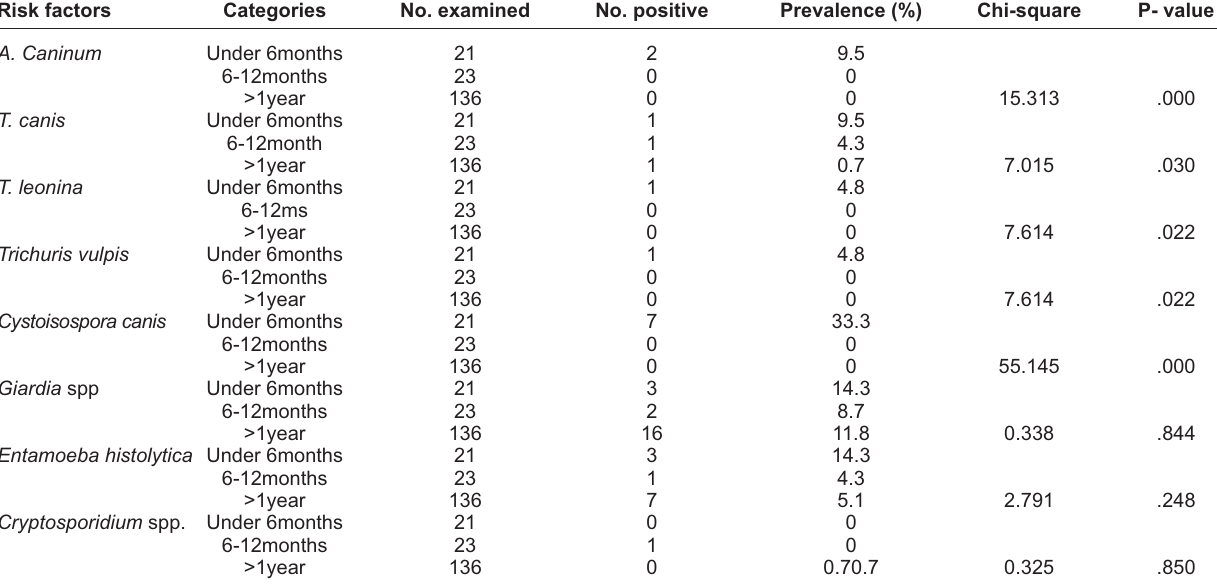
Table-3: Prevalence of parasite species in relation to age in police and house dogs. Risk